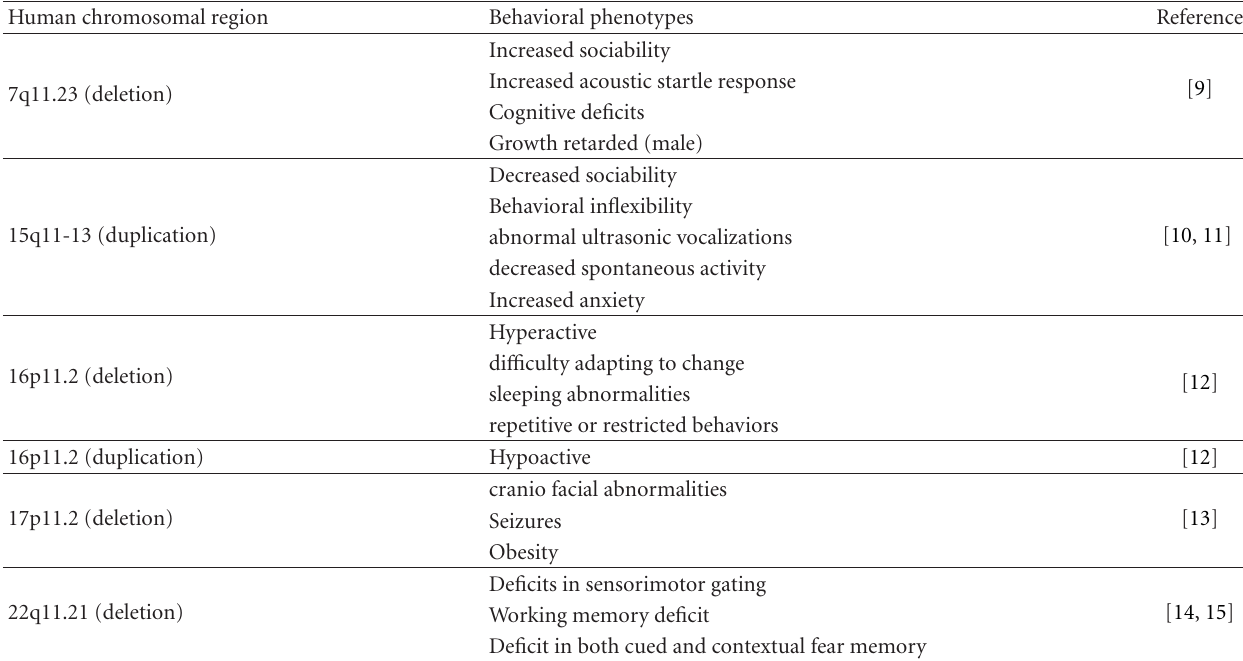
Table 1: Behavioral phenotypes of mouse